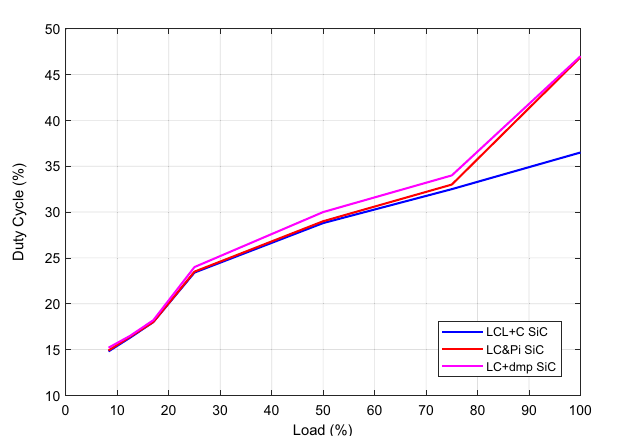
Figure 35. Load change versus duty